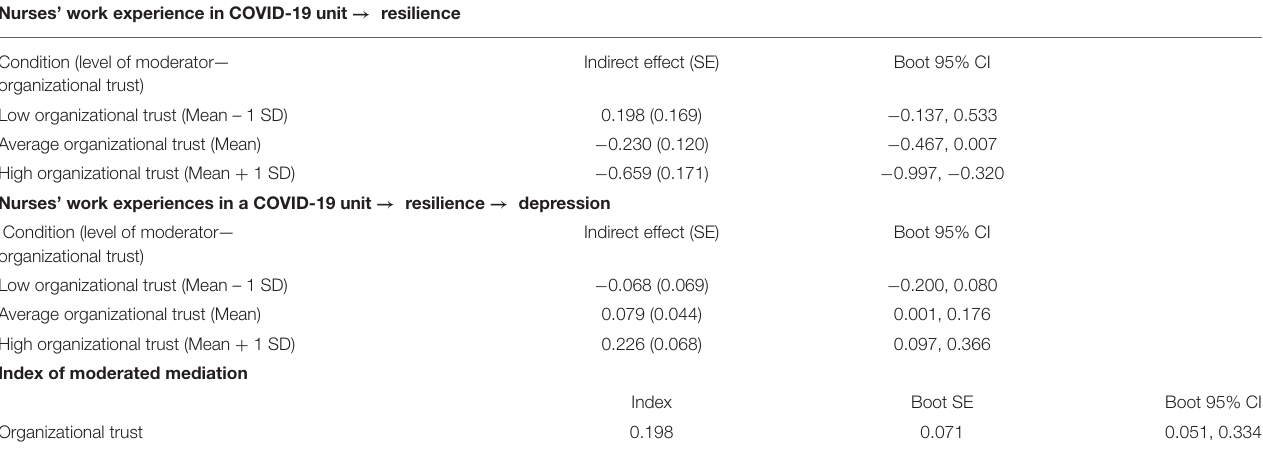
TABLE 3 | Indirect effect of nurses’ work experiences in a COVID-19 unit on depression and moderated mediation of organizational trust ( N = 132). Nurses’ work experience in COVID-19 unit →